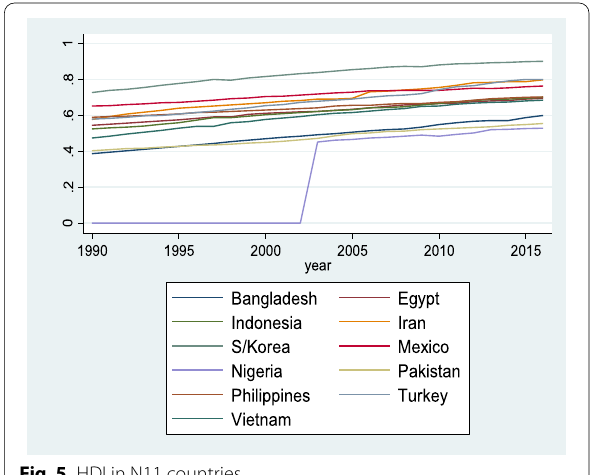
Fig. 5 HDI in N11